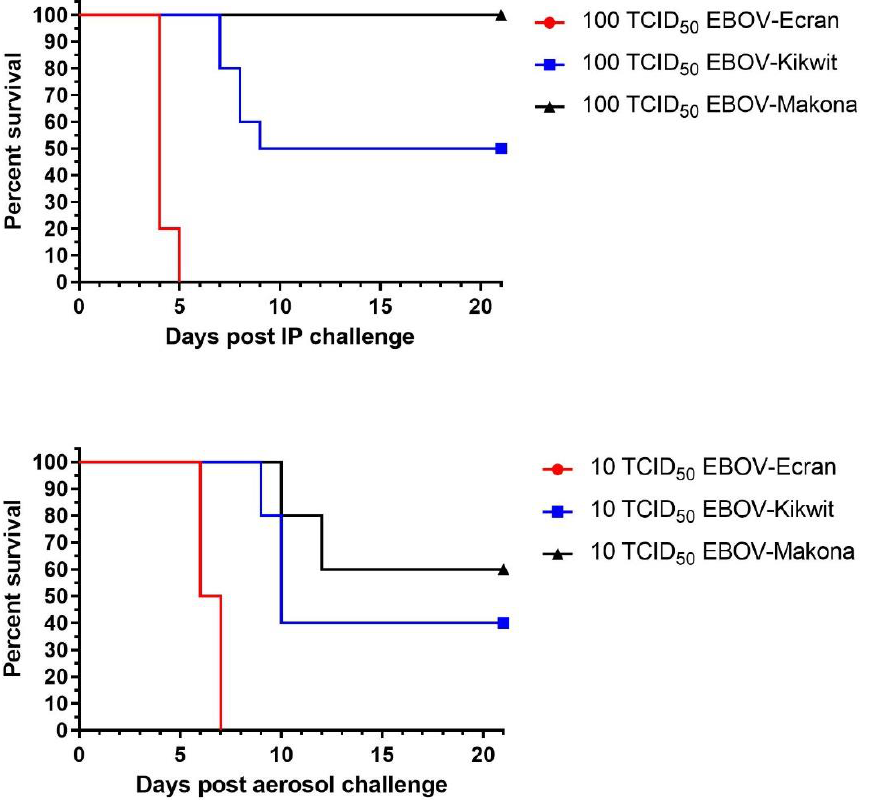
Figure 3. Indicative comparison of the lethality of different EBOV variants. Data from multiple experiments have been combined to give an indication of the difference in survival between EBOV- Ecran (Yambuku variant, red), EBOV-Kikwit (Blue), and EBOV-Makona (black) after a 100 TCID 50 IP challenge ( top ) or a 10 TCID 50 retained dose aerosol challenge ( bottom ).